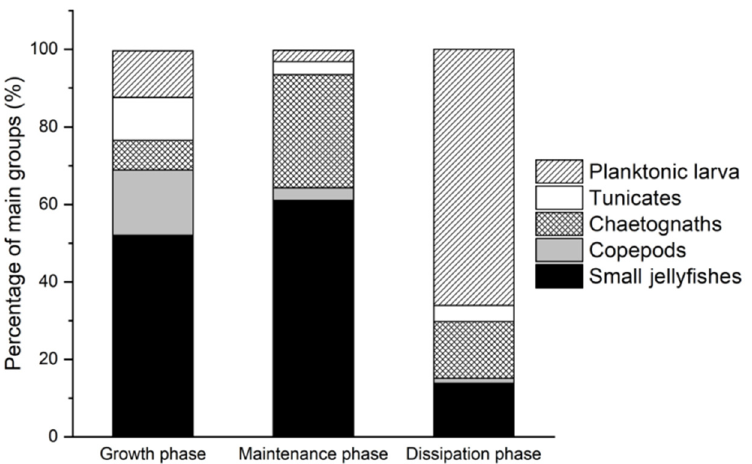
Figure 6. Percentages of major zooplankton groups (small jellyfishes, copepods, chaetognaths, tu- nicates, and planktonic larvae) in different phases of the P. donghaiense bloom.